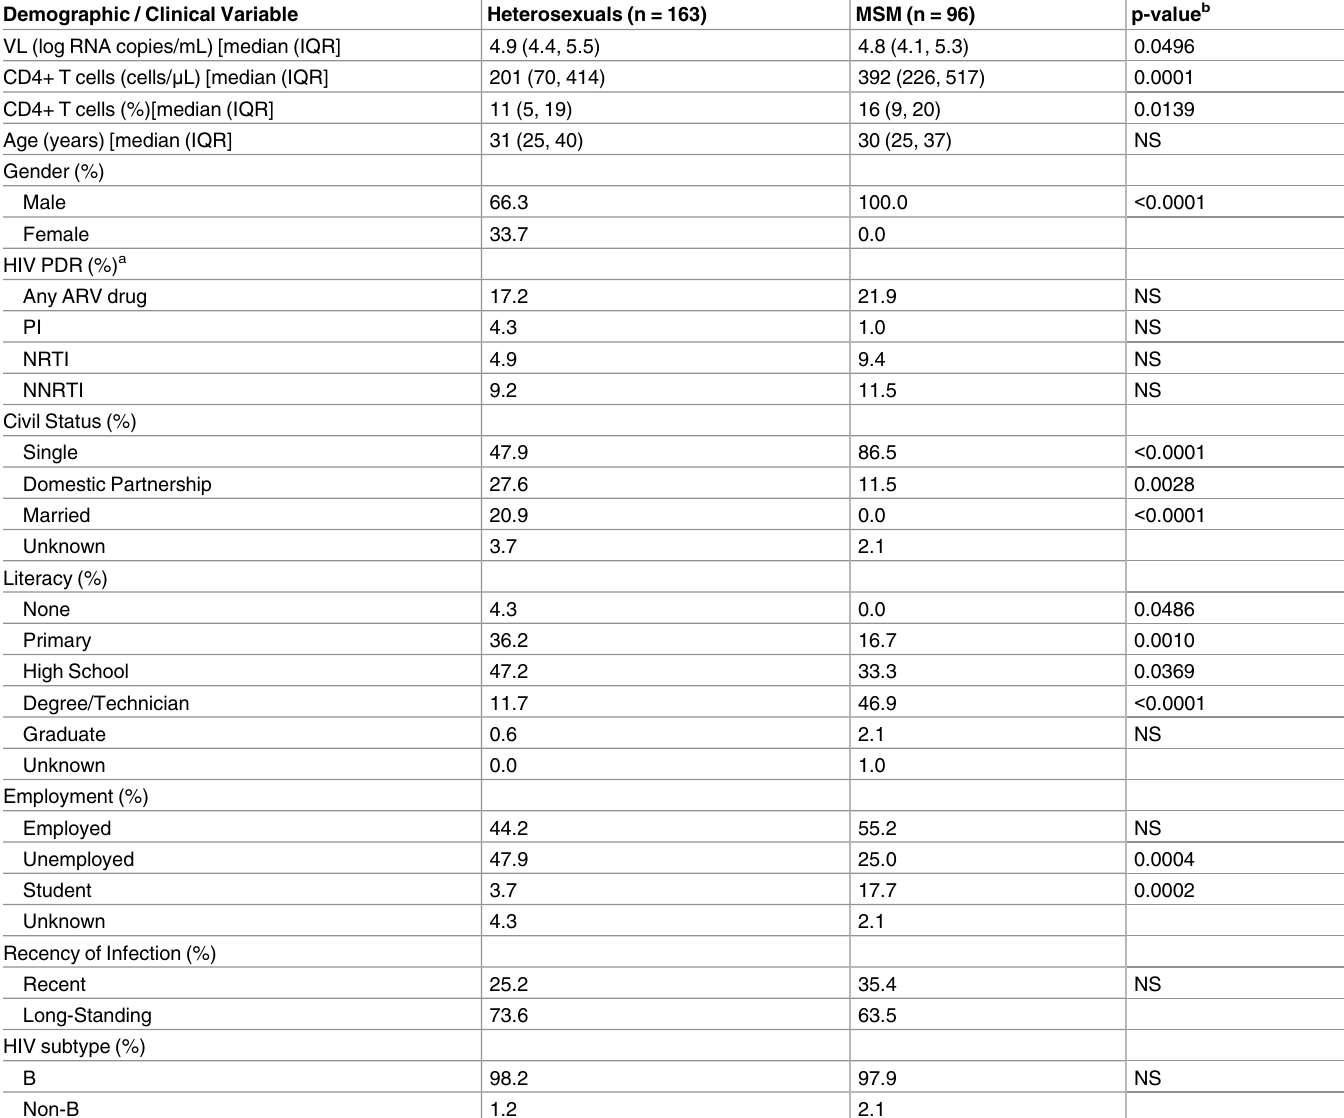
Table 4. HIV PDR and demographic variables in heterosexuals and